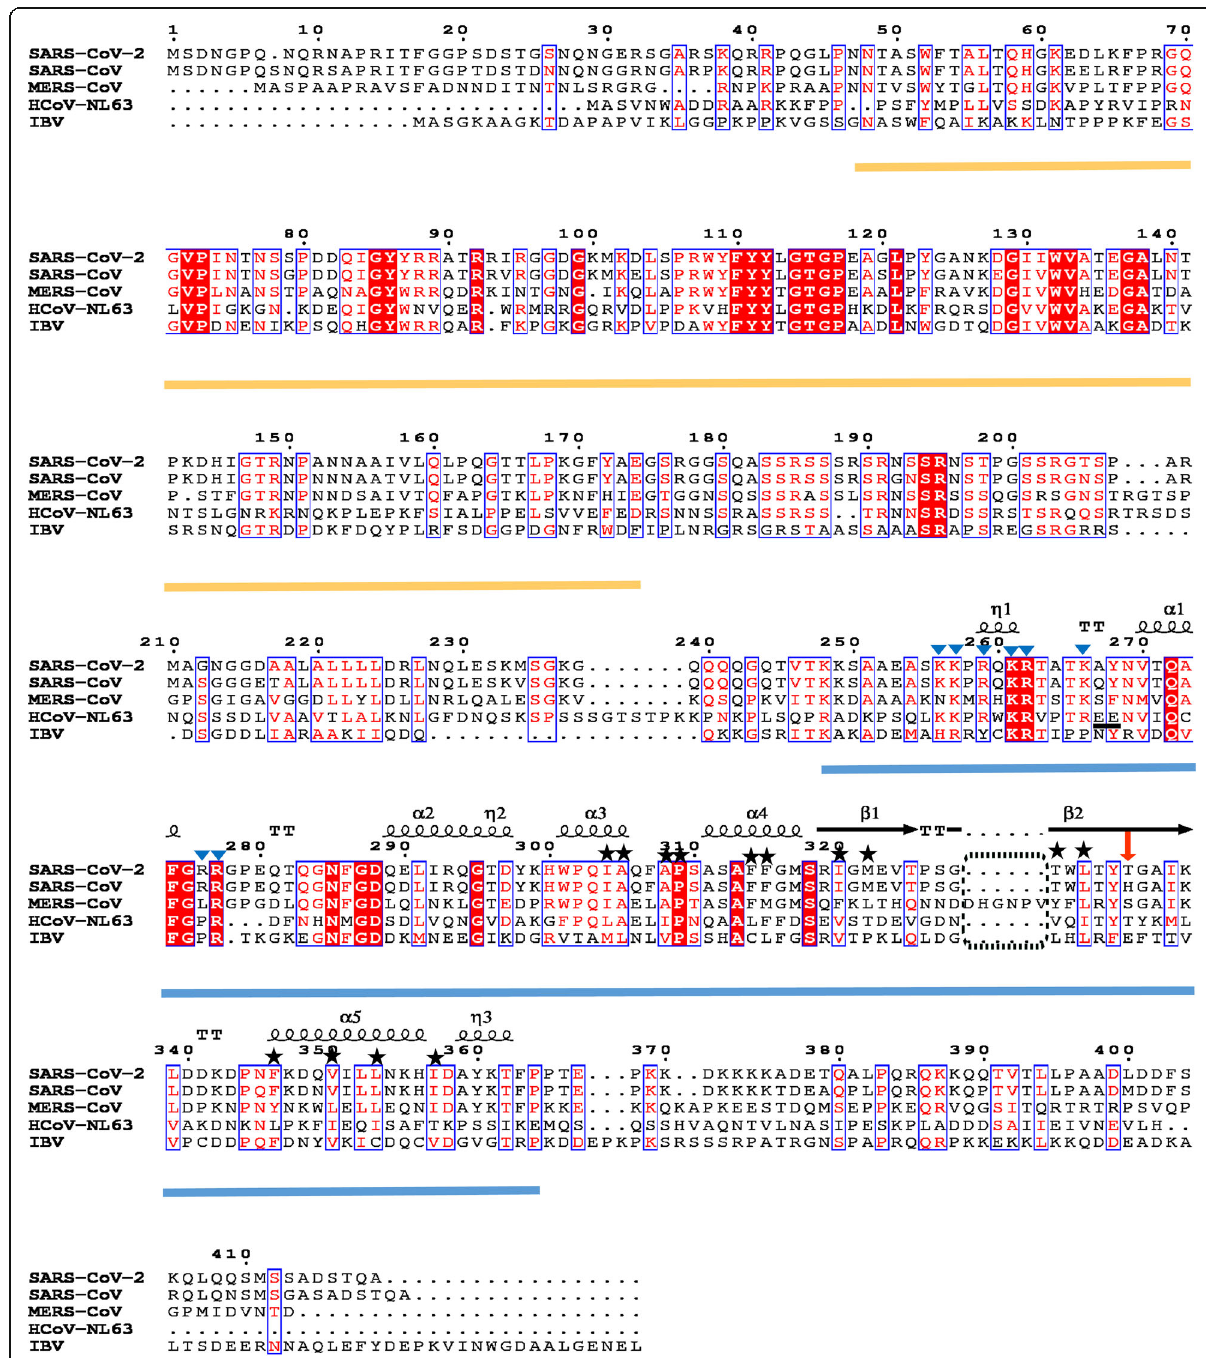
Fig. 4 Multiple sequence alignment of N proteins among different CoVs. The sequence accession numbers are: SARS-CoV-2, GenBank: MN908947; SARS-CoV, GenBank: AY274119; MERS-CoV GenBank: KC164505; HCoV-NL63, GenBank: AY567487; and IBV, GenBank: M95169. SARS-CoV-2, SARS- CoV and MERS-CoV belong to beta -CoV genus. HCoV-NL63 is from alpha -CoV group while IBV is from gamma -CoV group. The N-terminal domain (NTD) and C-terminal domain (CTD) of the N protein are marked by orange and blue lines, respectively. The secondary structures of the SARS- CoV-2 N-CTD are indicated. The long insertion of the β -hairpin in the MERS-CoV N-CTD is indicated by a dashed black box. The residues involved in forming two hydrophobic cores for the N-CTD dimerization are labelled with the black stars. The basic residues referring to construct the positive charge groove are indicated by blue triangles. Two acidic residues Glu243/244 of HCoV-NL63 are underlined by a short black line. The non-conserved Thr334 between SARS-CoV-2 and SARS-CoV is indicated by a red arrow. This figure was generated by the program ESPript